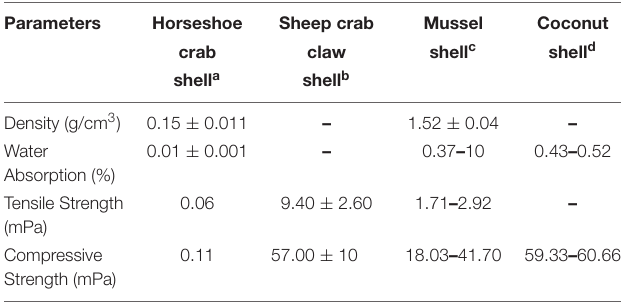
TABLE 5 | Mechanical-physical characteristics of the mangrove horseshoe crab ( Carcinoscorpius rotundicauda ) and some other crustaceans